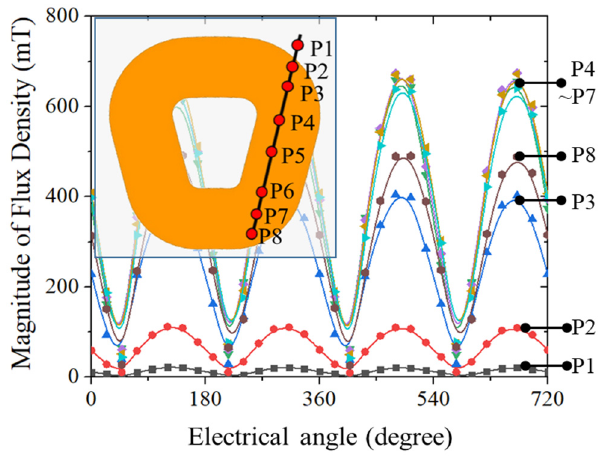
Figure 7. Magnetic flux density changes over time in the coils during the no-load condition.